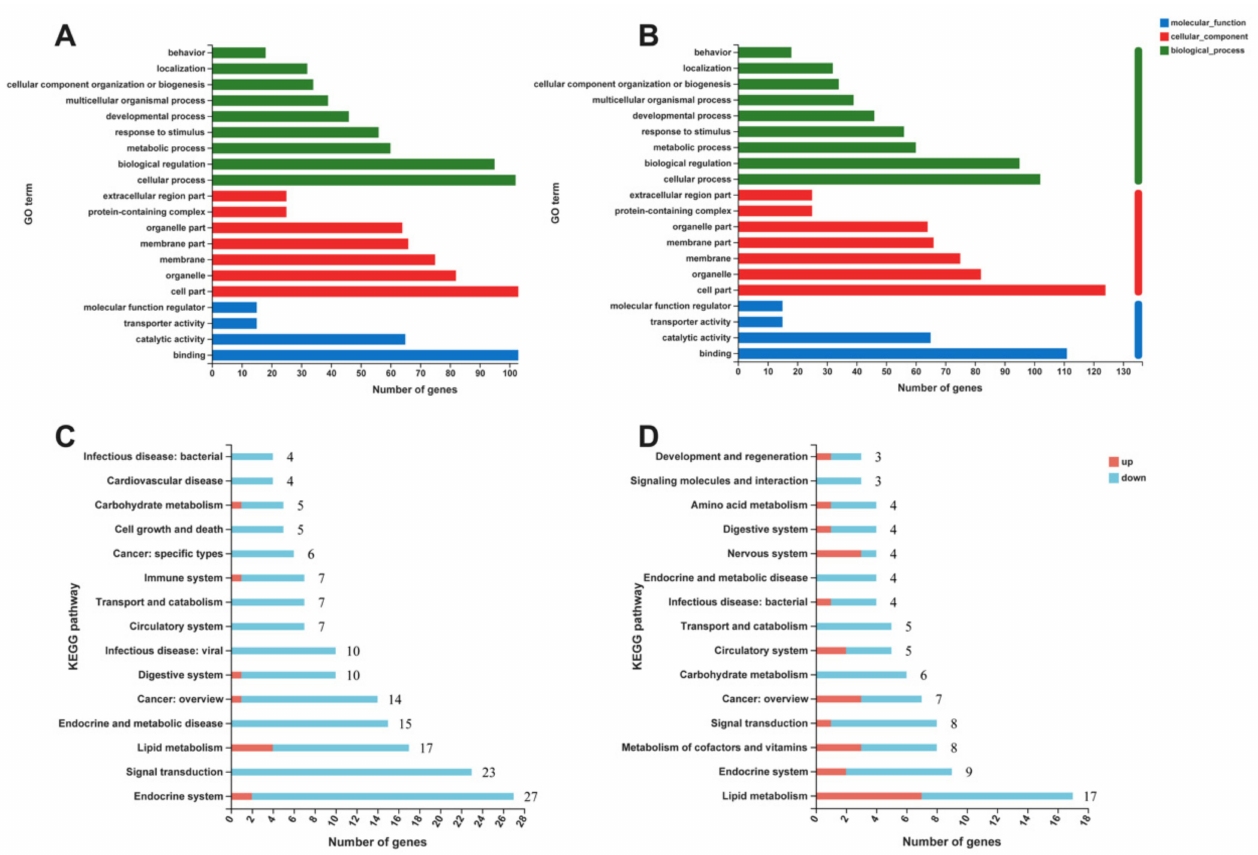
Figure 8. Gut microbiota depletion altered the expression of genes involved in lipid metabolism. ( A ) GO analysis of all differential genes that were altered by HFD feeding compared with chow diet fed mice; ( B ) GO analysis of all differential genes that were altered by Abx treatment in HFD-fed mice; ( C ) KEGG analysis of all differentially expressed genes that were altered by HFD feeding compared with chow diet fed mice; ( D ) KEGG analysis of all differential genes that were altered by Abx treatment in HFD-fed